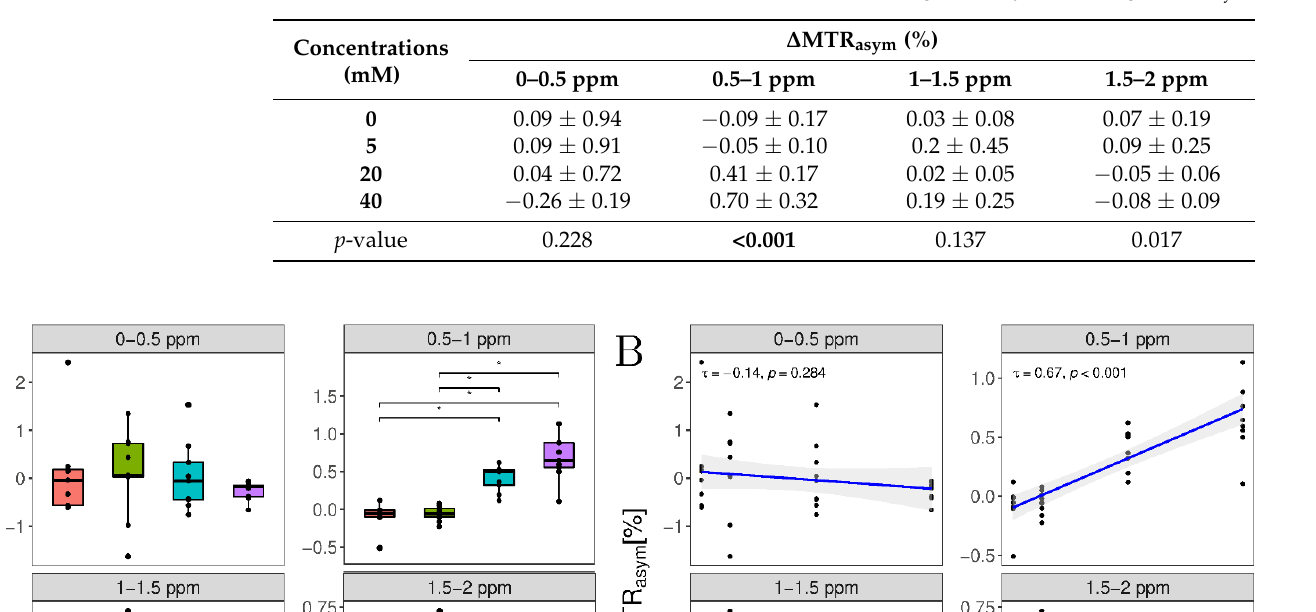
Table 3. Absolute changes of the asymmetry magnetization transfer ratio ( ∆ MTR asym ) values under various lactate concentrations in situ. Absolute changes were determined by relating the post-injection ∆ MTR ∆ MTR asym values to the pre-injection asym values. The non-parametric Friedman test was used to determine whether the different lactate concentrations differed significantly concerning ∆ MTR asym .